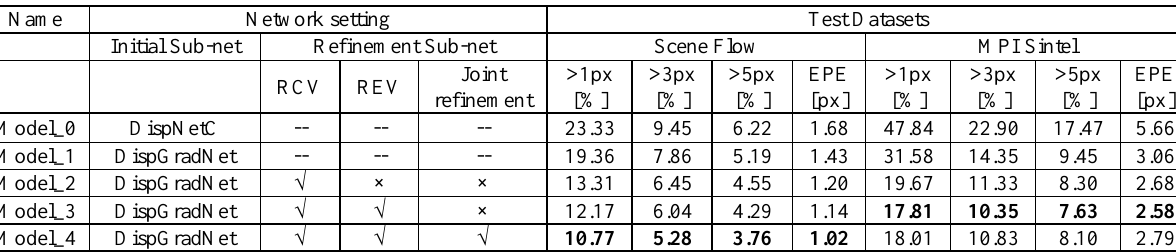
Table 1. Results achieved on the Scene Flow dataset and Sintel dataset when employing different network structures.